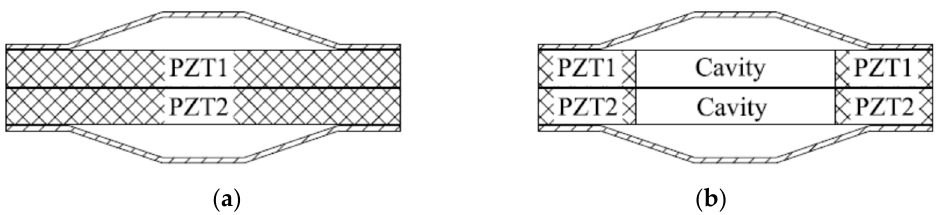
Figure 22. Structure diagrams of dual drive cymbal. ( a ) Two piezoelectric discs ( b ) Two piezoelectric rings.